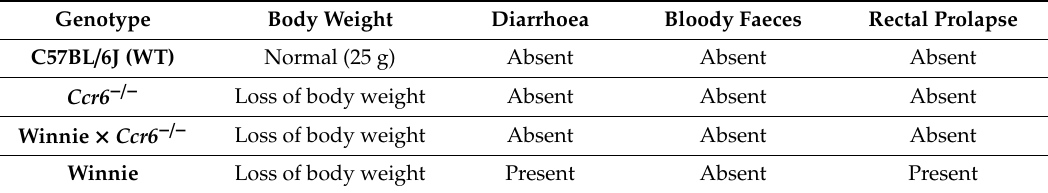
Table 2. Summary of the disease activity index in the four genotypes from Day 1 to Day 22.